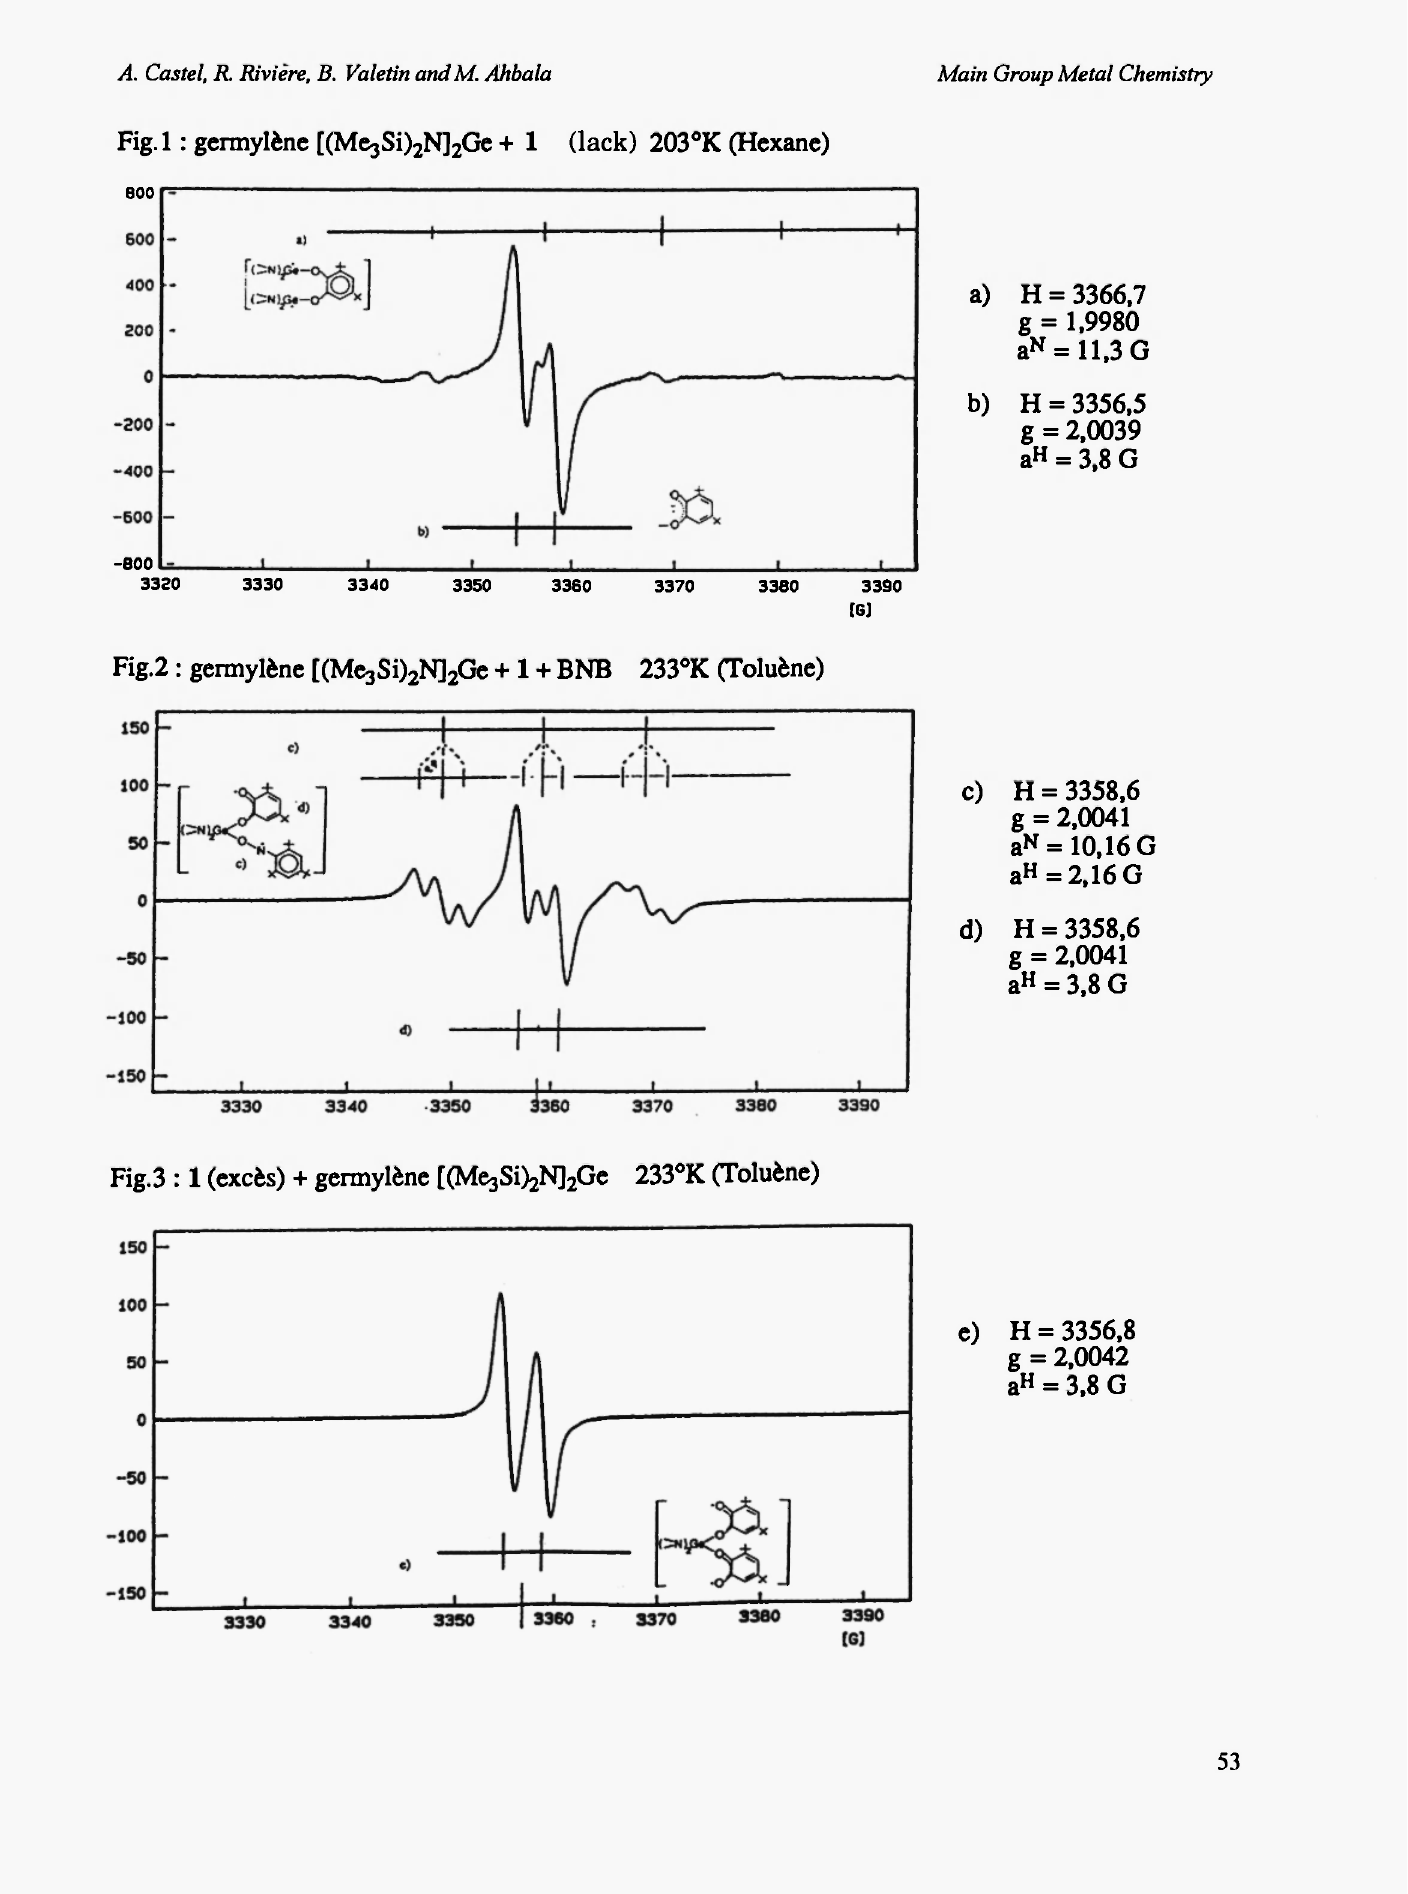
Fig. 1: germylfene [ ( M e ^ S i ^ N ^ Ge + 1